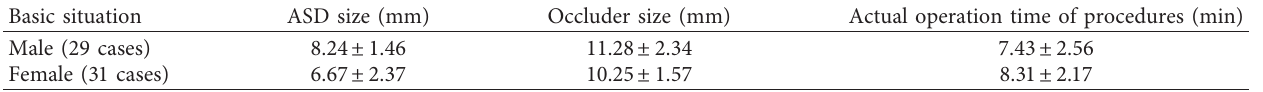
Figure 3: Optimization of echo views: (a) subcostal section shows the guidewire going through the inferior vena cava; (b) parasternal short- axis section of the aorta shows the catheter going through the ASD into the left atrium; (c) subcostal biatrial section shows the sheath going through the inferior vena cava; (d) subcostal biatrial section shows the sheath going through the ASD into the left atrium; (e) parasternal four-chamber view shows release of the left disc of the device; (f) apical four-chamber view shows release of the right disc of the Table 1: The basic clinical situation of the 60 children.